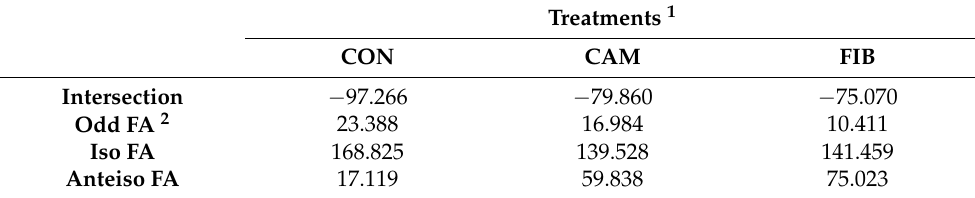
Table 3. Fisher’s classification functions.